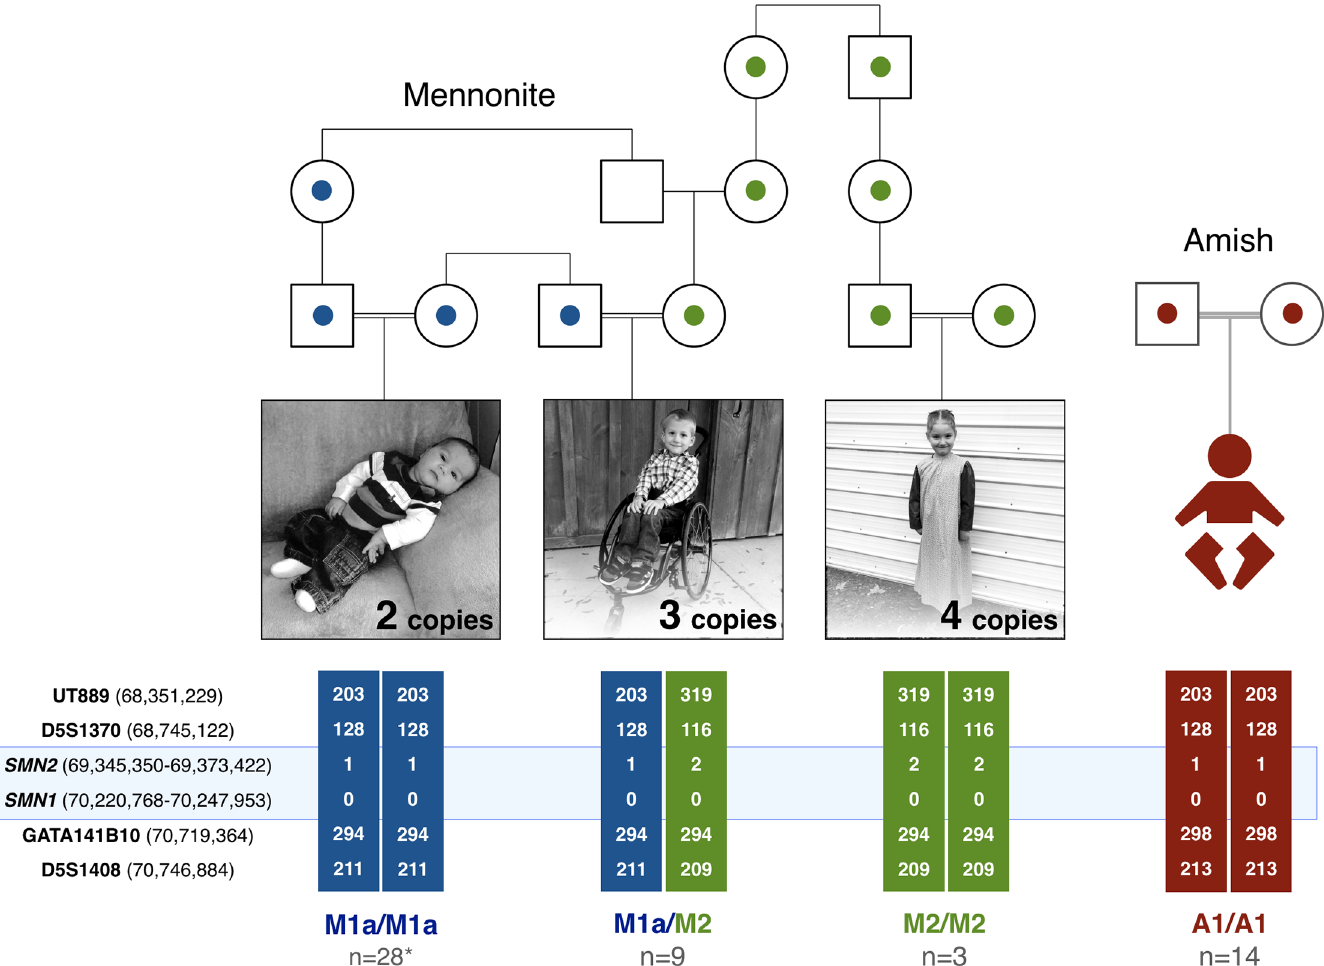
Fig 2. Segregation of SMA haplotypes. (A) To map SMA haplotypes, we used DNA microsatellite markers in close proximity to SMN1 and SMN2 on chromosome 5q13. Among Mennonites, pathogenic SMN1 deletions segregated on four different haplotypes that harbored either 1 (blue; M1a, M1b, M1c) or 2 (green; M2) copies of SMN2 to produce genotypes comprising 2 (M1/M1; n = 30), 3 (M1/M2; n = 9), or 4 (M2/M2; n = 3) copies of SMN2 . (B) A single ancestral haplotype (A1) with 1 copy of SMN2 was inferentially shared among all 14 Amish patients homozygous for the A1/A1 genotype (red; 2 copies of SMN2